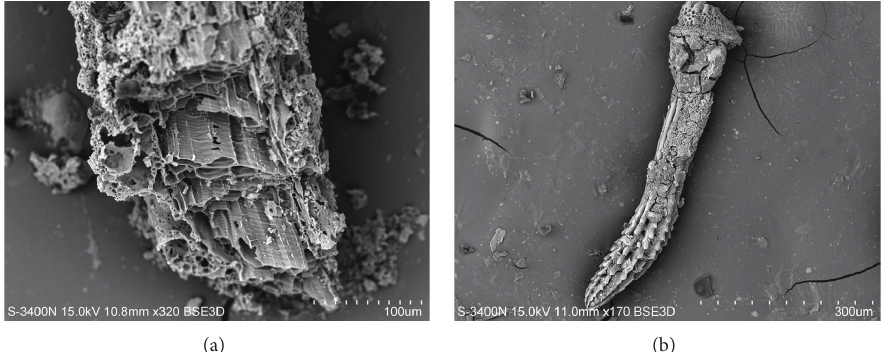
Figure 5: (a) Fragments of sea organics (hypothetically a part of a sponge) and (b) needle of sea urchin Scaphechinus mirabilis from a snow sample taken in the Sadgorod District of Vladivostok. Scanning electron microscopy in secondary electrons. (a) Magnification × 320. (b) Magnification ×